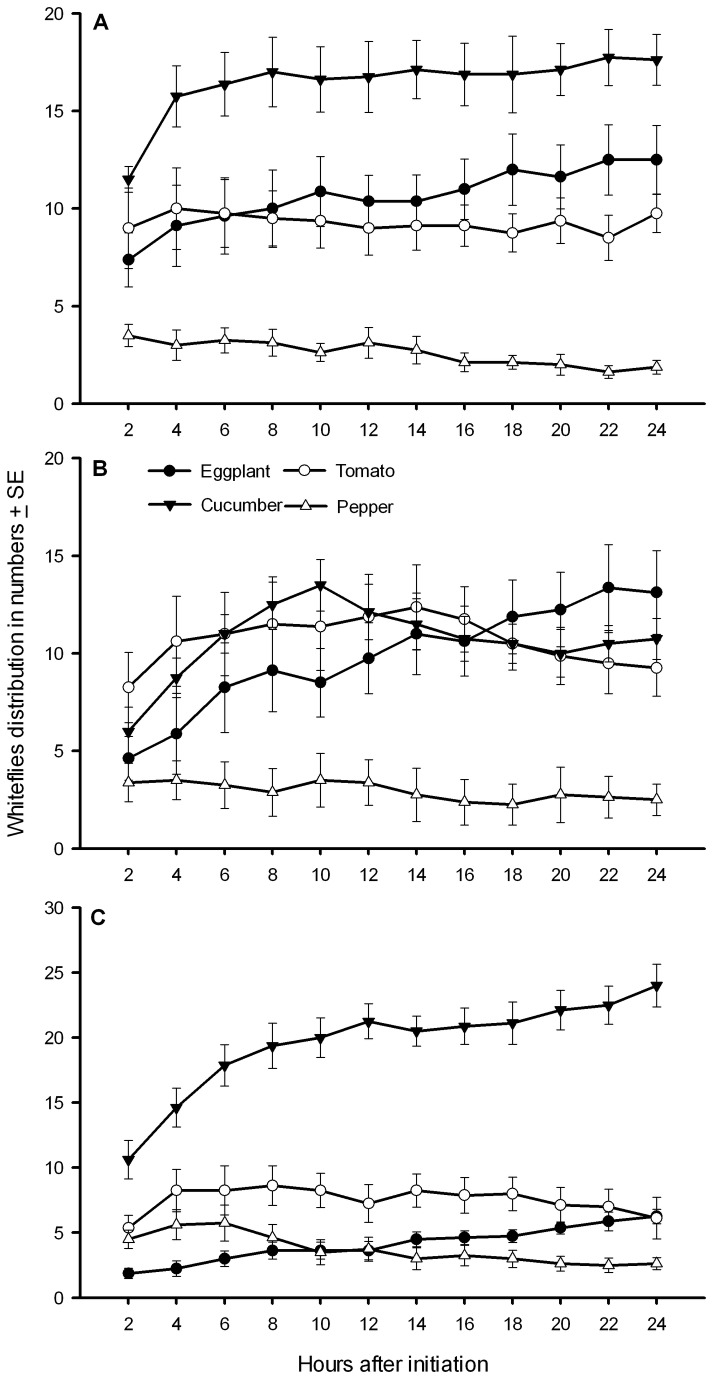
Numbers of B. tabaci adults (mean ± SE) on leaf discs of the four host plants at 2-h intervals for 24 h in a choice bioassay.A, B and C are denoted as Bemisia-eggplant, Bemisia-tomato, and Bemisia-cucumber, respectively.